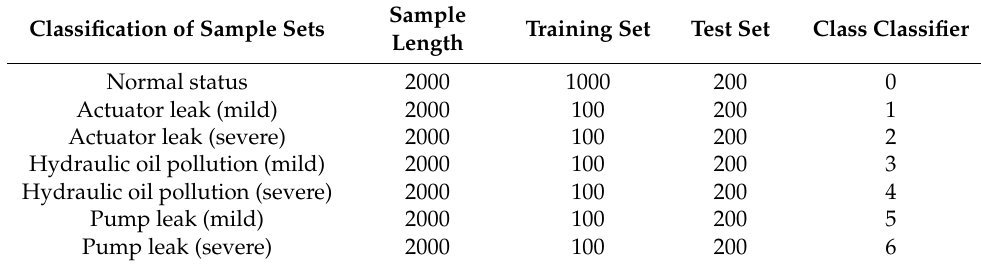
Table 3. Specific parameters and classifications of the generated fault datasets.